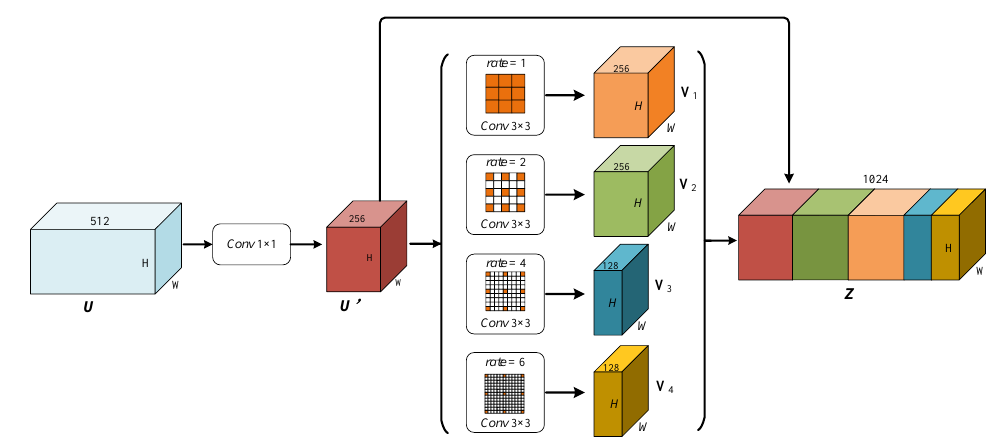
Figure 3. Context information scene perception module.